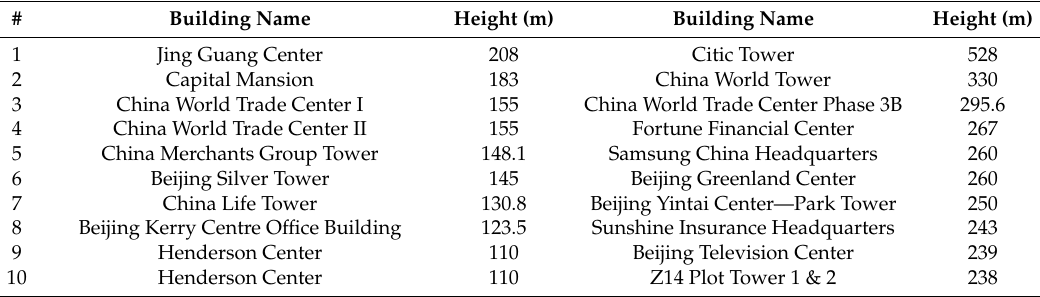
Figure 4. Beijing in 2000 and 2020. Table 14. Beijing’s 10 tallest skyscrapers in 2000 and 2020.